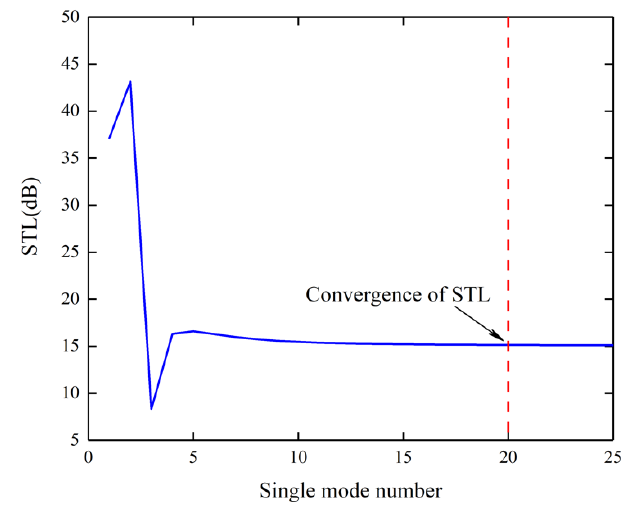
Figure 7. Convergence check of the research structure at 2000 Hz.